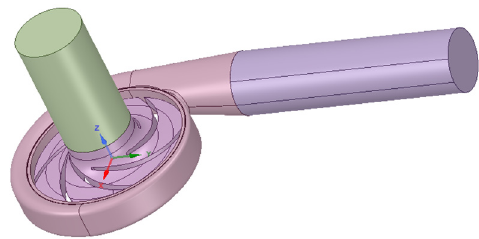
Figure 3. Full channel model of centrifugal pump.